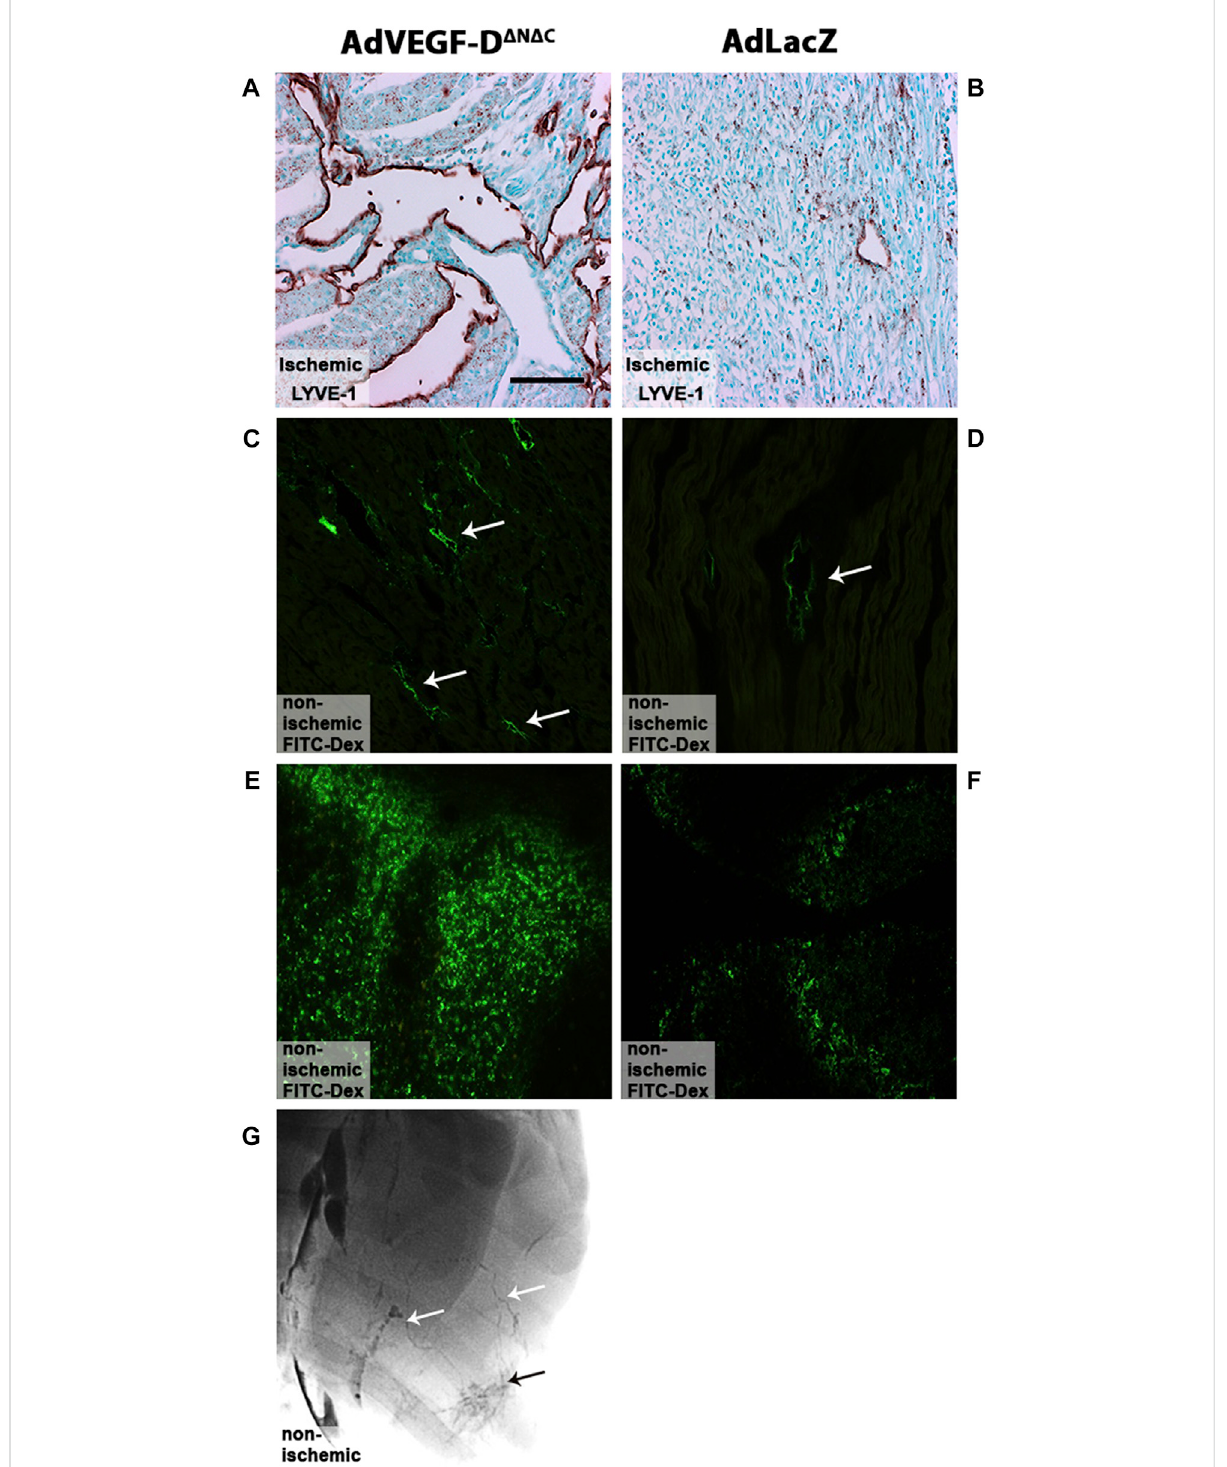
FIGURE 3 AdVEGF-D Δ N Δ C gene transfer induces lymphangiogenesis. (A) AdVEGF-D Δ N Δ C induced lymphangiogenesis. (B) AdLacZ did not affect lymphatic vessels. (C,D) FITC labeled fl uorescentdextran wastaken up bythelymphatics inboth groups(arrows). (E,F) 30 min after injection large quantities of the tracer were also found in mediastinal lymph nodes in both groups. (G) Draining lymphatic vessels (white arrows) and dense lymphatic network (black arrow) in the gene transfer area were visualized with lymphangiography in AdVEGF-D Δ N Δ C group. LYVE-1 staining (A,B) , Representative images, maximal trasduction area. Magni fi cation ×200. Scale bar 100